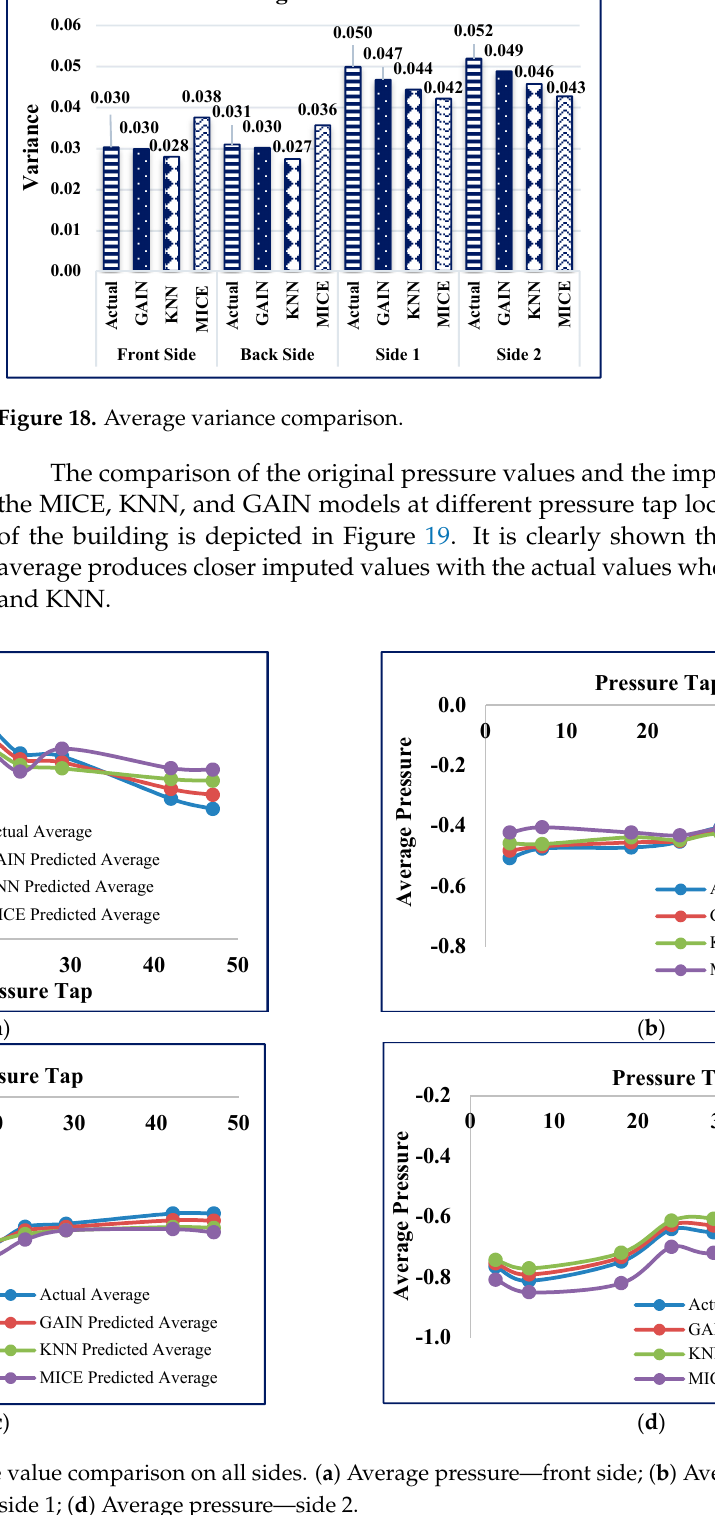
side; ( c ) Average pressure—side 1; ( d ) Average pressure—side 2.